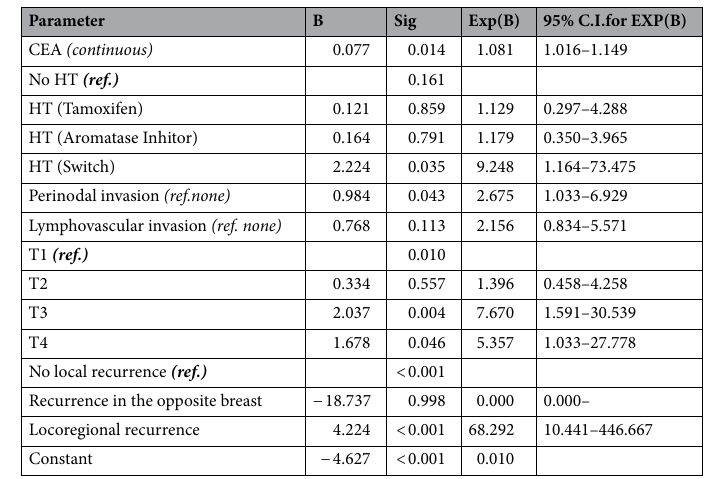
Table 7. Multivariate logistic regression analysis of demographic, therapeutic and histopathological parameters between Group 1 & 2. HT hormone therapy, T T category.